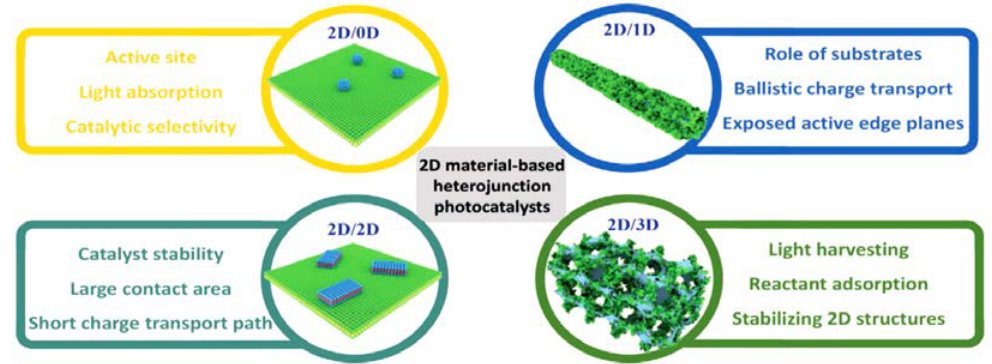
Figure 5. The schematic illustration of 2D heterojunction photocatalysts with various configurations, applications, and properties, adapted from [41].